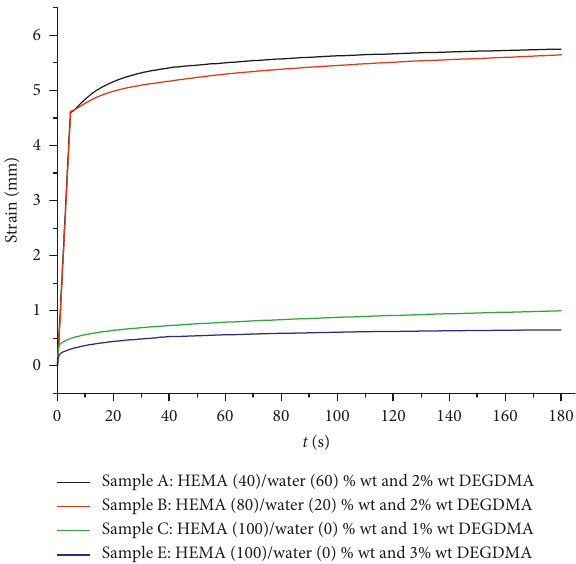
Figure 3: Strain versus time to A, B, C, and E samples.